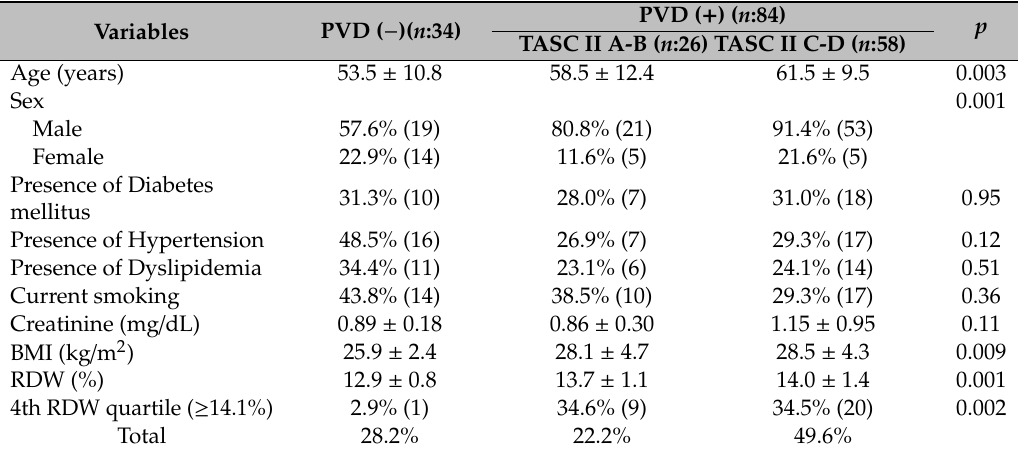
Table 2. Distribution of clinical and demographic characteristics of the patients according to presence and severity of PVD.